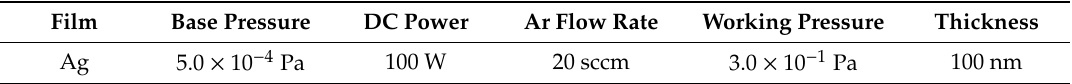
Table 1. Deposition parameters of Ag film.